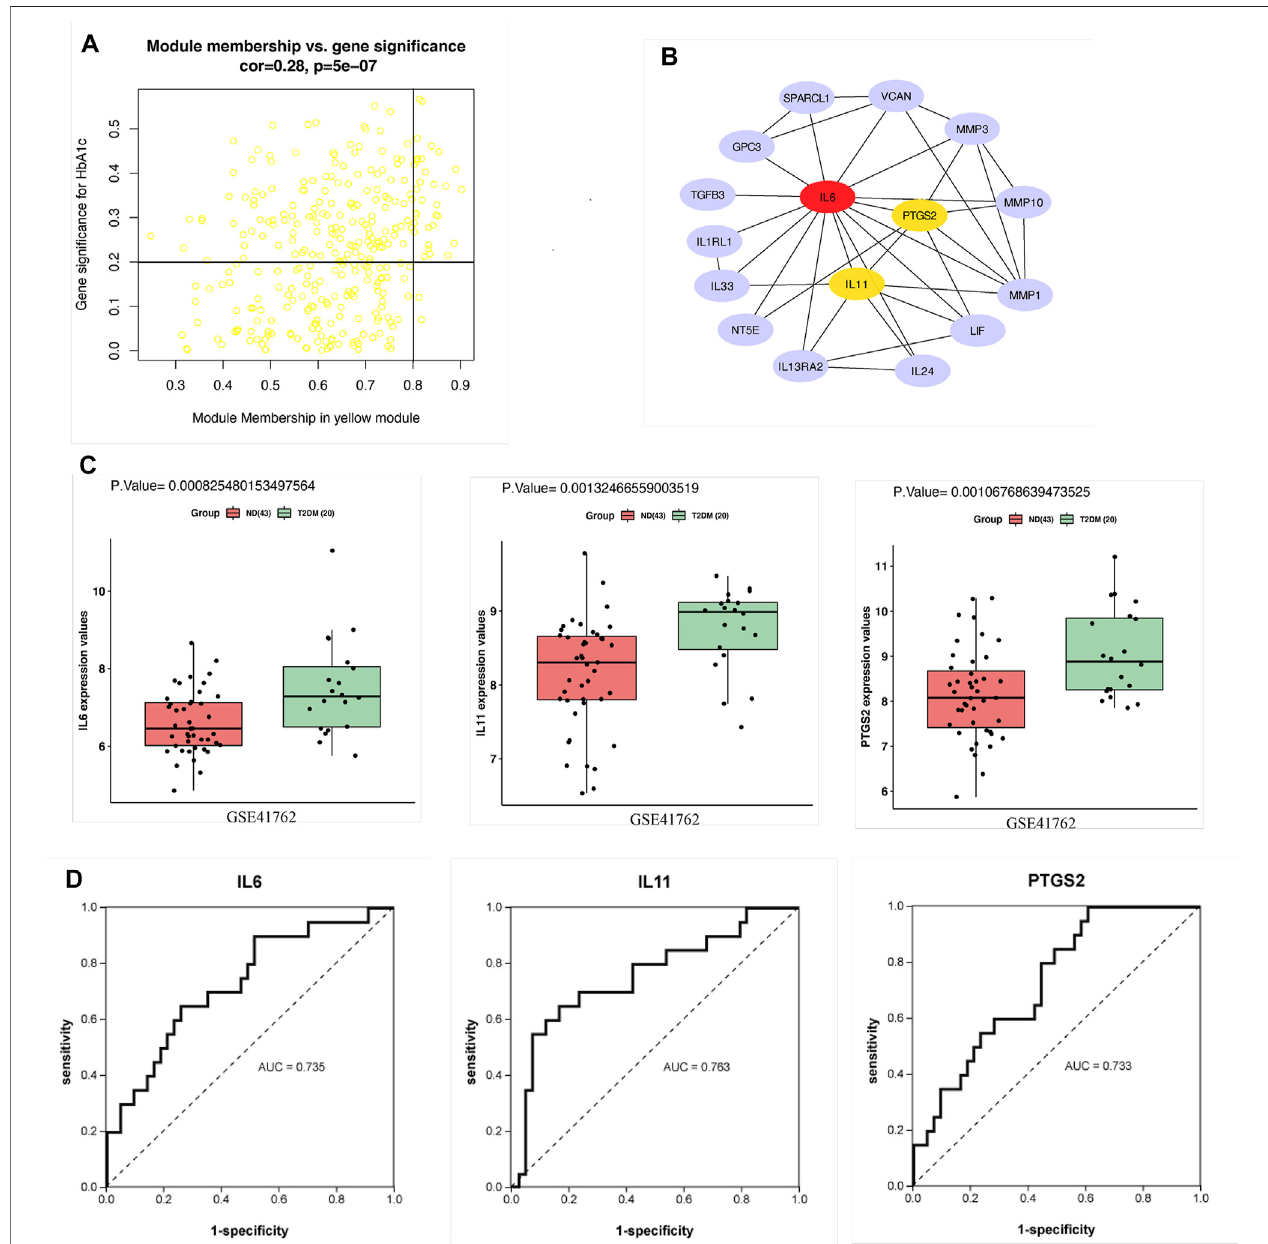
FIGURE4| Hubgenescreening. (A) Scatterplotofmoduleeigengenesintheyellowmodule. (B) PPInetworkof30candidatehubgenesintheyellowmodule.The hubgeneswerescreenedaccordingtothedegreeofconnectivity.Ahigherdegreeisrepresentedbyadarkercolor,whichindicatesthatthegenesaremorecentral.The top genes were IL6, IL11 and PTGS2. (C) Expression of hub genes in GSE41762. (D) ROC curve analysis of the ability of IL6, IL11 and PTGS2 to distinguish between T2DM and ND samples. ROC curves were used to illustrate the diagnostic ability, sensitivity and speci fi city of the genes. Genes with AUC values > 0.7 have certain diagnostic value. T-testing was performed to compare the means of the two